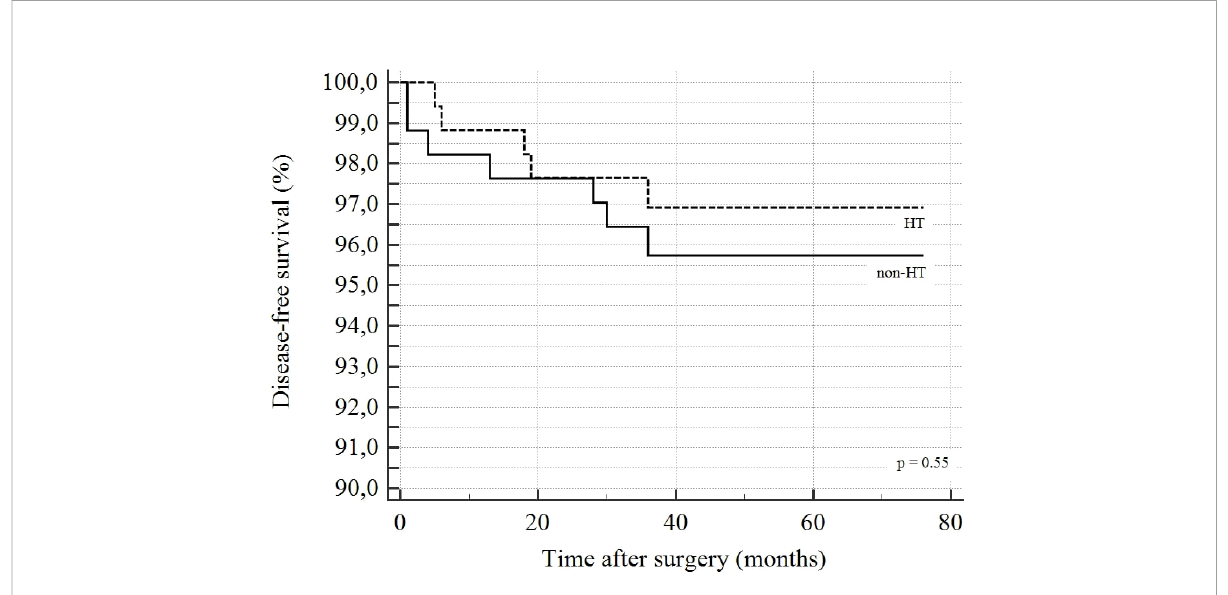
FIGURE 1 Kaplan-Meier curves estimating disease-free survival in HT-DTC and